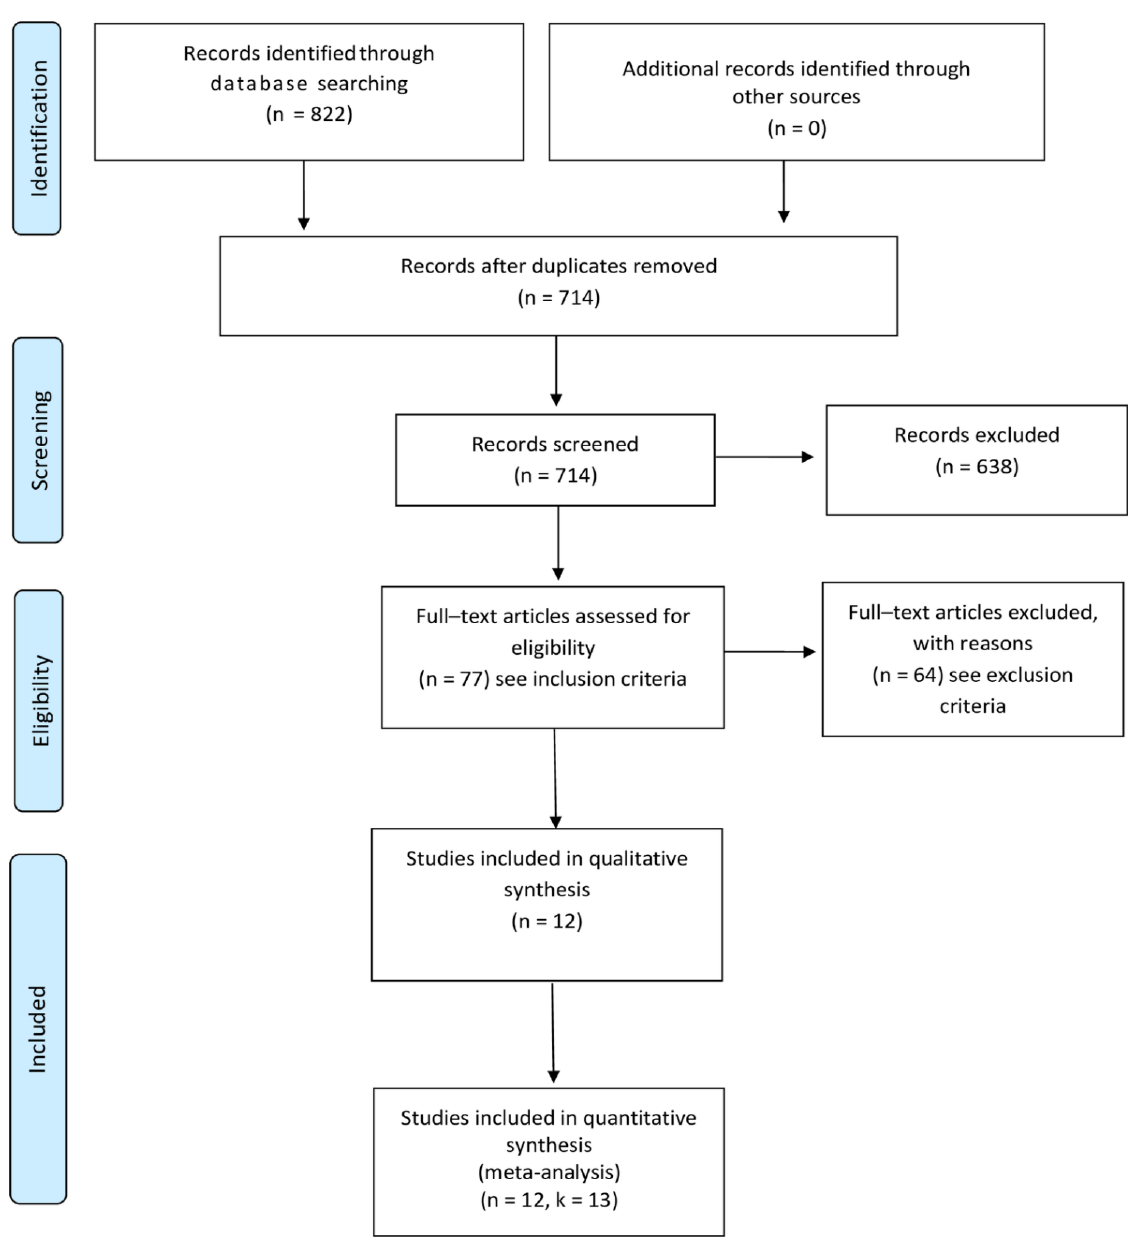
Figure 1. Preferred Reporting Items for Systematic Reviews and Meta-Analyses (PRISMA Statement) [22].